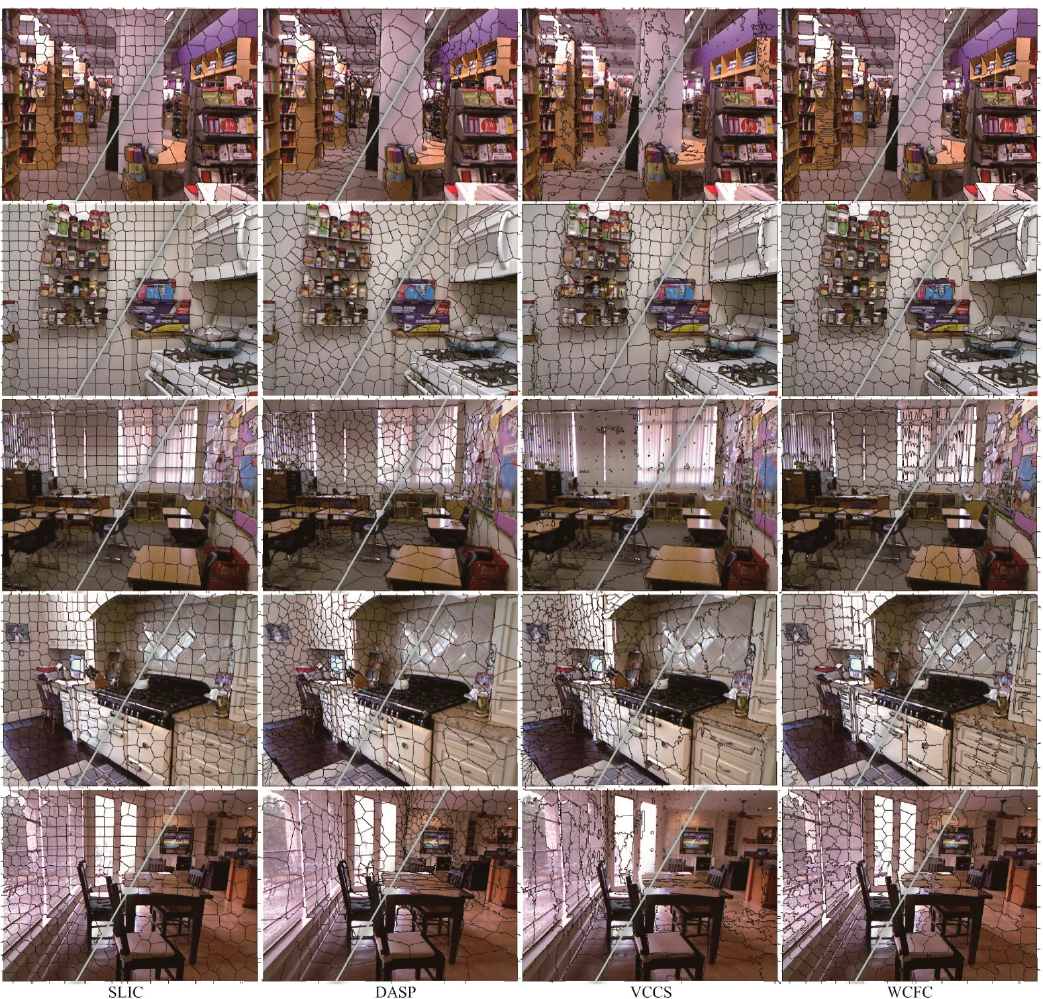
Figure 4. Visual comparison of superpixels produced by simple linear iterative clustering (SLIC), depth-adaptive superpixels (DASP), voxel cloud connectivity cegmentation (VCCS) and our WCFC method. The average superpixel size is approximately 500 pixels in the upper left of each image and approximately 300 in the lower right.